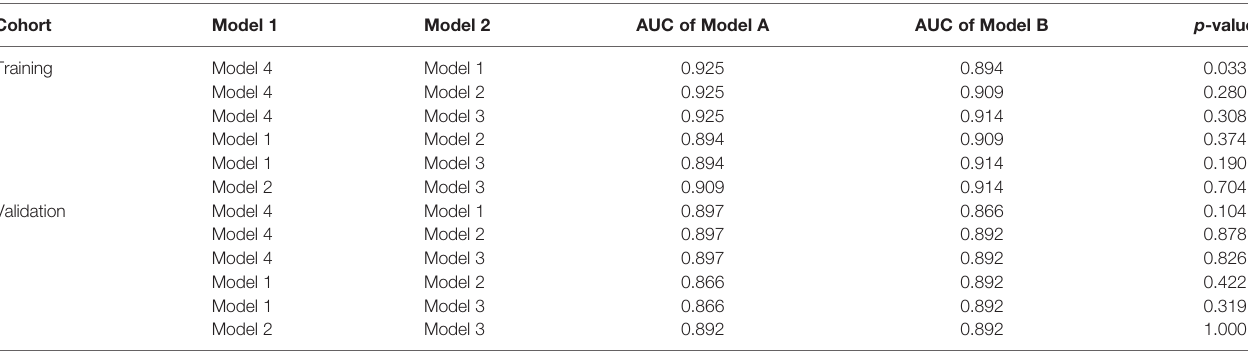
TABLE 4 | The DeLong test results of the four models.